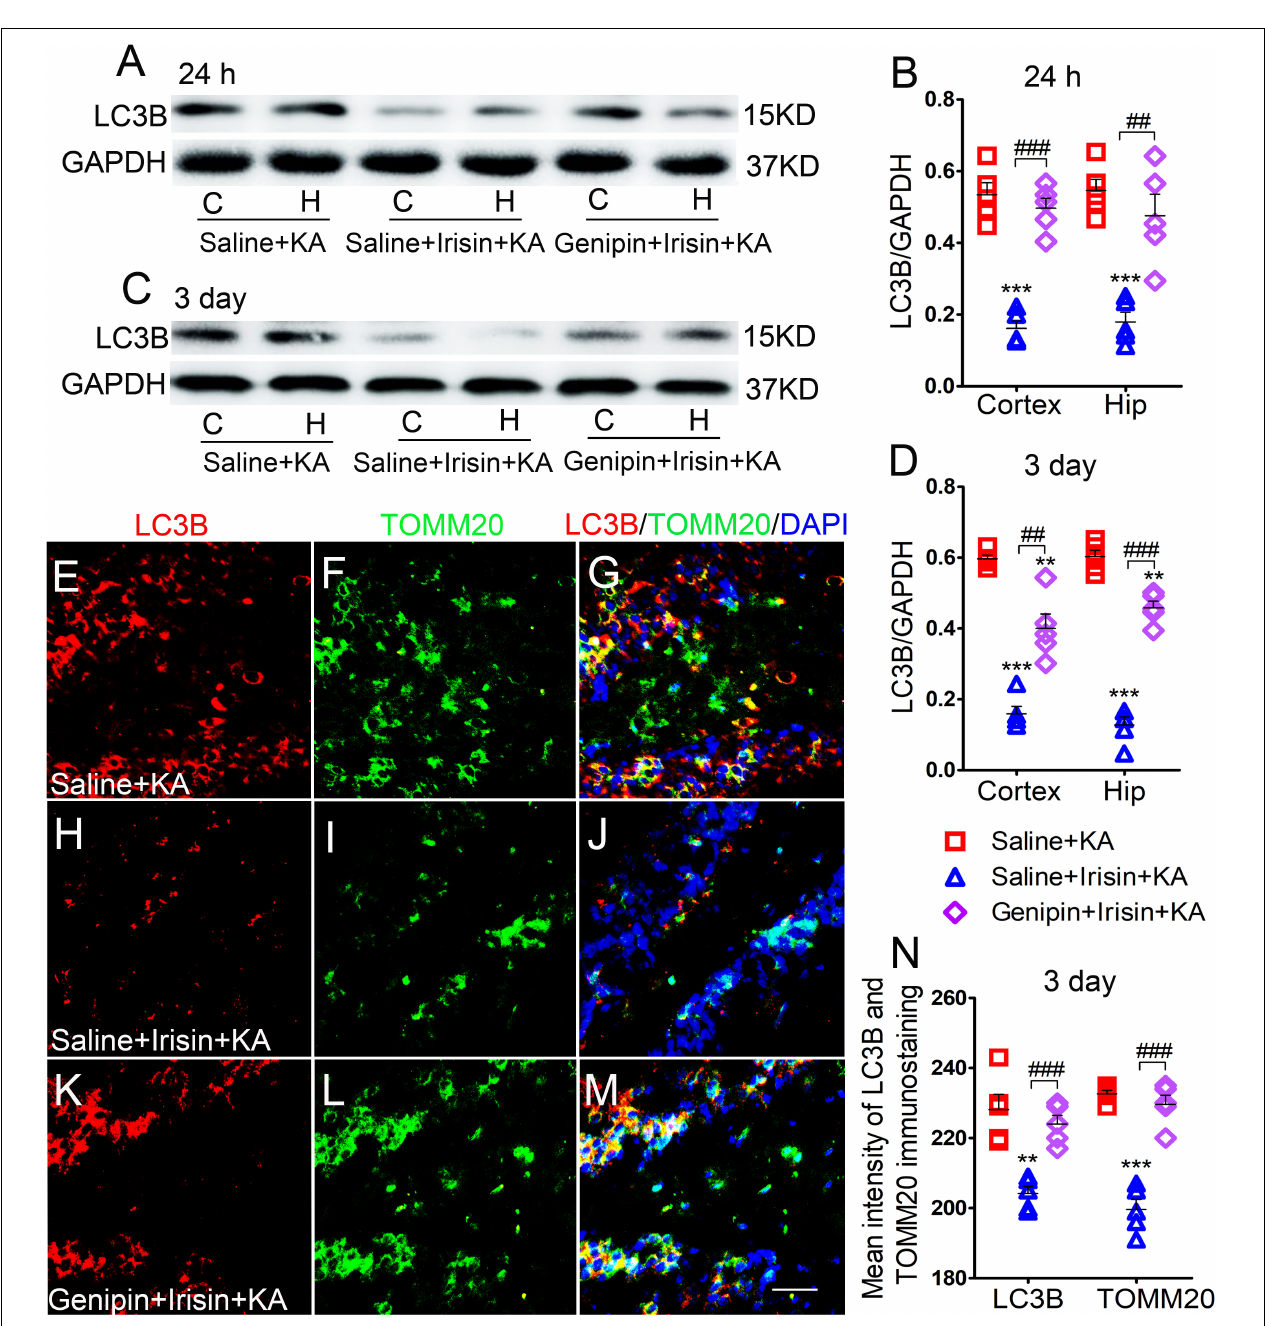
FIGURE 7 | The reduction of mitophagy due to exogenous irisin treatment was reversed after genipin administration. (A–D) The levels of mitophagy-related protein LC3B after genipin treatment was detected by western blot ( A–D , n = 5/group). (E–N) The mean fluorescence intensity of LC3B and TOMM20 immunostaining in DG ( n = 5/group). LC3B (red), TOMM20 (green), DAPI (blue). Bar = 30 µ m. ** P < 0.01, *** P < 0.001 compared with controls; ## P < 0.01, ### P < 0.001 compared with each other (One-way ANOVA with Dunnett’s T3 post hoc test). C, cortex; EC, entorhinal cortex; H/Hip, hippocampus; LC3B, microtubule-associated protein light chain 3B; TOMM20, translocase of outer mitochondrial membrane 20; DG, dentate